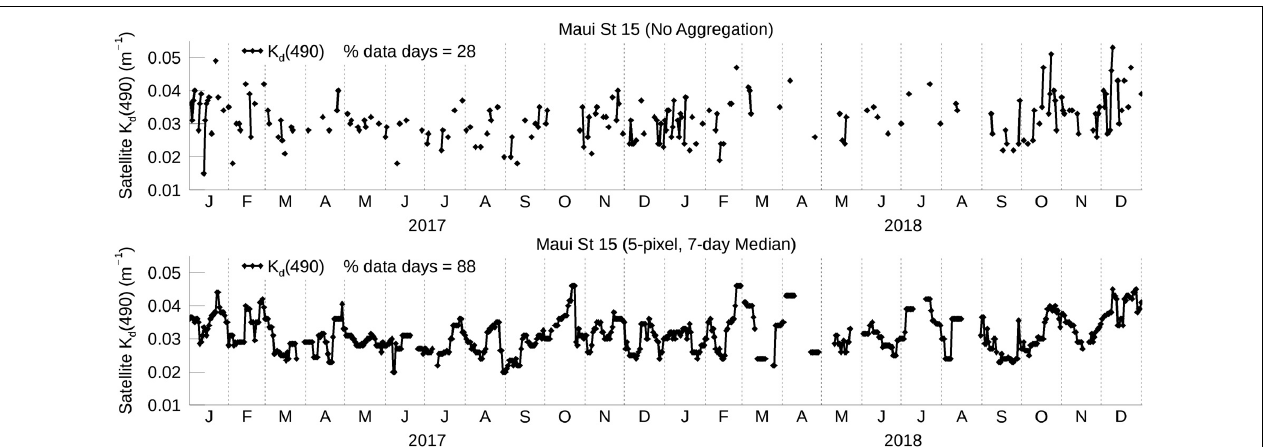
FIGURE 6 | Time Series of K d (490) from 2017 to 2018 at Maui Station 15 before aggregation (top) and after taking the median from a rolling 5-pixels, 7-days spatiotemporal window centered on the date (bottom) demonstrating improved data coverage. The RMS difference between the non-aggregated and aggregated time series is 0.005 m − 1